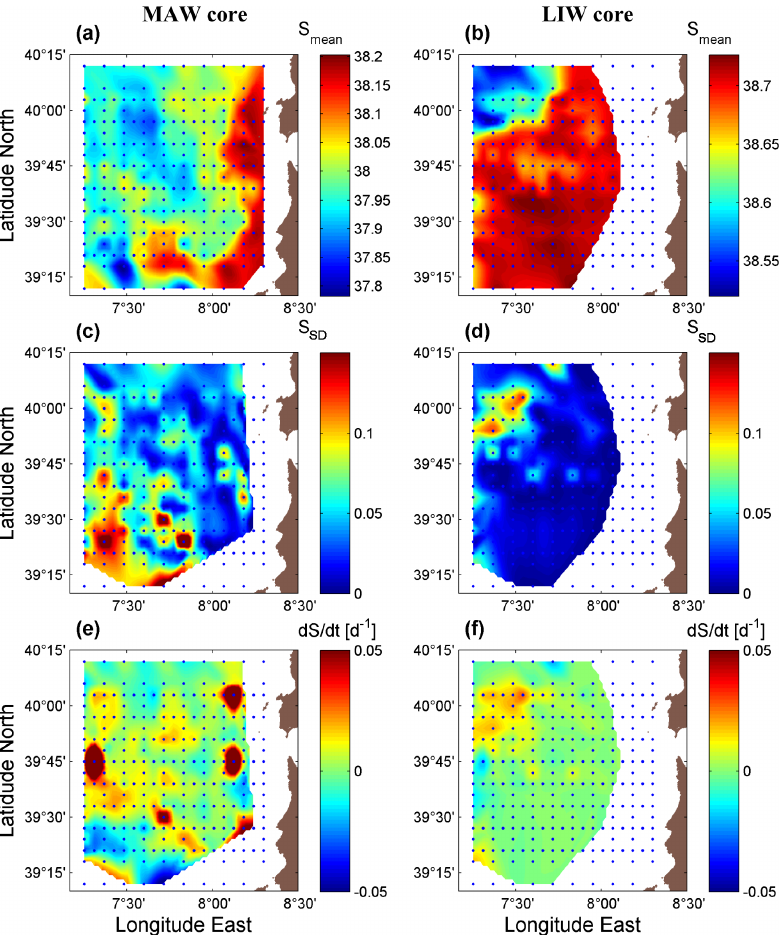
Figure 11. Mean salinity ( S mean ) , standard deviation ( S SD ) , and linear temporal change in salinity per day (d S /d t (d − 1 )) in the cores of (a, c, e) MAW ( σ (cid:50) = 28 . 2kgm − 3 ) and (b, d, f) LIW ( σ (cid:50) = 29 . 06kgm − 3 ) based on all collected data of the station grid (blue